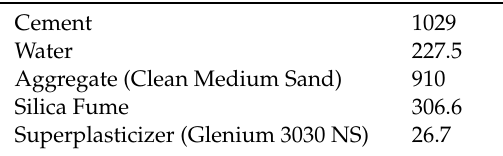
Table 2. Mixture Proportions of Ultra-High Performance Concrete (UHPC) (kg/m3) .